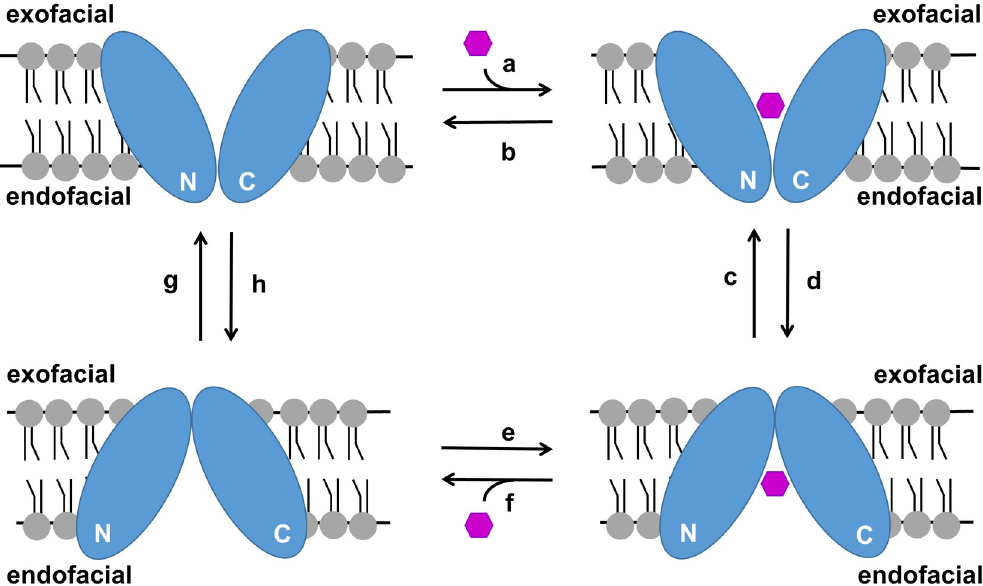
Fig 10. Simple carrier model illustrating the transport of glucose by an alternating access mechanism. Glucose can access the glucose binding site of PfHT from either the exofacial side or the endofacial side of the membrane but not simultaneously. N and C represent the N-terminal and C-terminal α -helical bundles of PfHT. Upon binding glucose, PfHT undergoes a series of conformational changes that allows the translocation of glucose through the central pore and its release from PfHT at the other side of the membrane. Transport is bidirectional and down the concentration